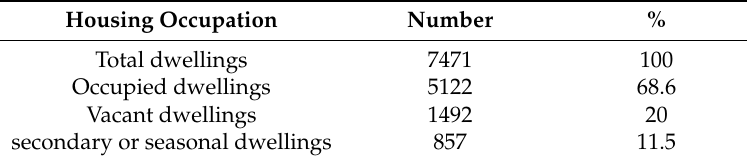
Table 2. Housing occupation in the city of Imzouren [20].